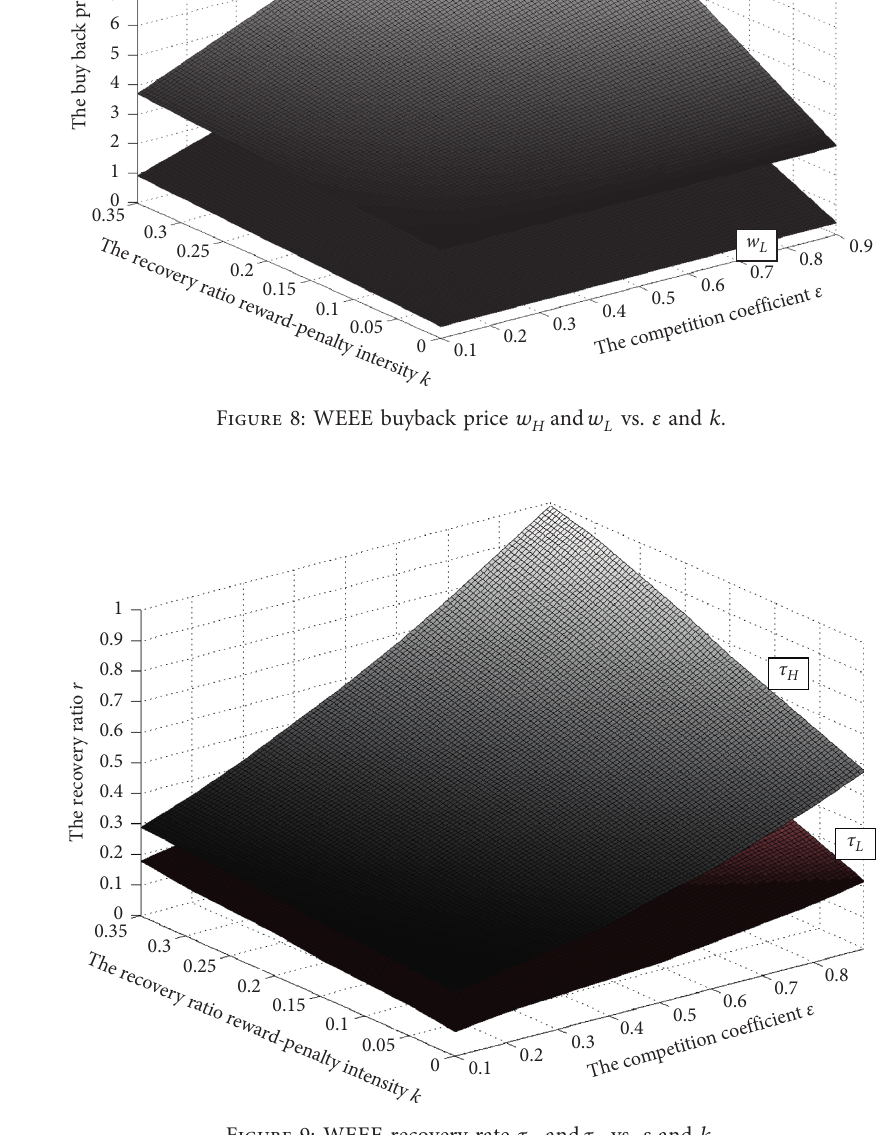
H and τ L vs. ε and